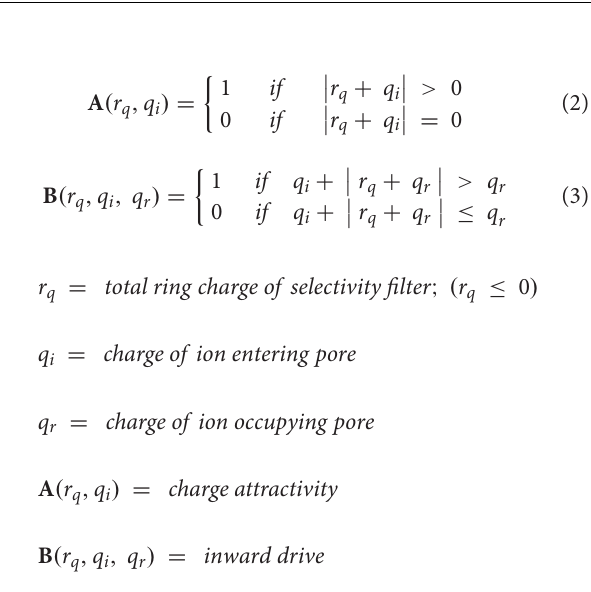
FIGURE 1 | Schematic of a synapse compartmentalizing the intracellular and extracellular spaces as regions of differing cation selectivities for their permeation through AMPA and NMDARs. Factors affecting permeability and selectivity within these receptor channels include among others, the relative size of ions (inset blue, top number )/atoms (inset gray, bottom number ), where numbers indicate radii in